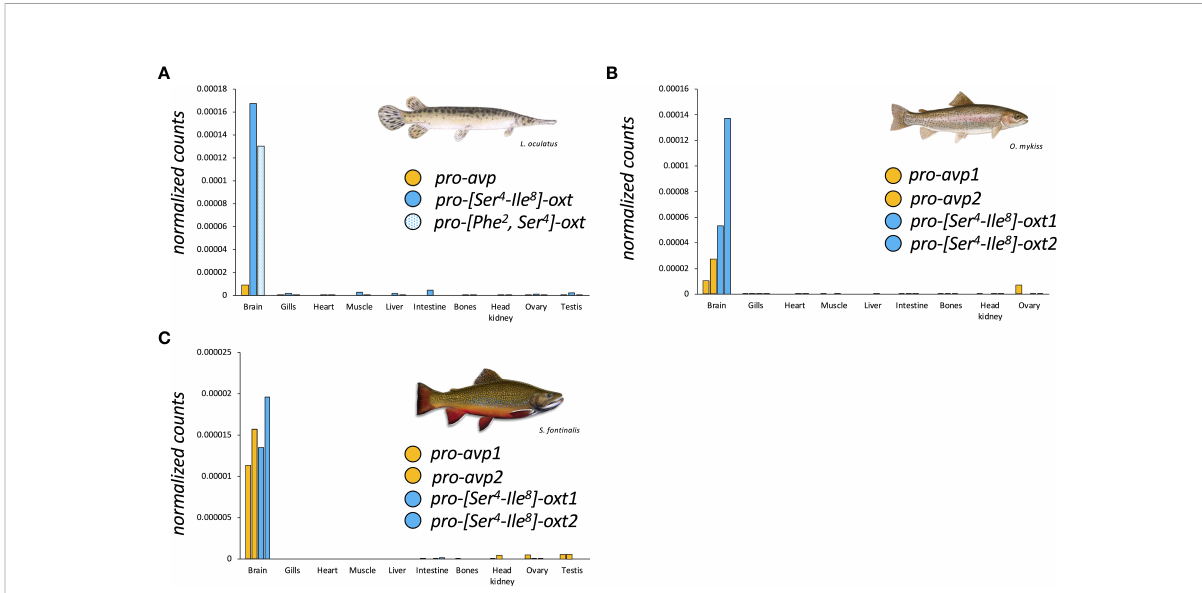
FIGURE 1 Tissue-speci fi c expression pro fi les of nonapeptide precursor coding genes in spotted gar (A) , rainbow trout , Oncorhynchus mykiss (B) , and brook trout, Salvelinus fontinalis (C) derived from the Phylo fi sh RNA-seq database (www.phylo fi sh.signae.org) queried on June 1 st , 2022